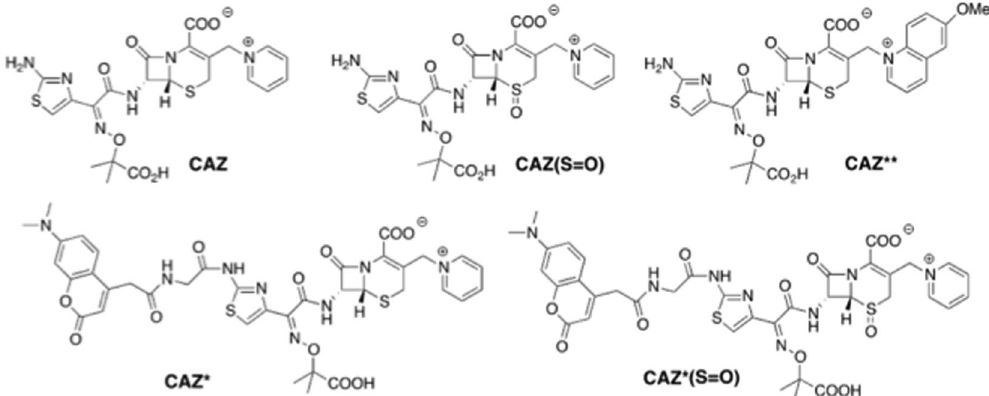
Figure 1. Structures of CAZ derivatives and fluorescent